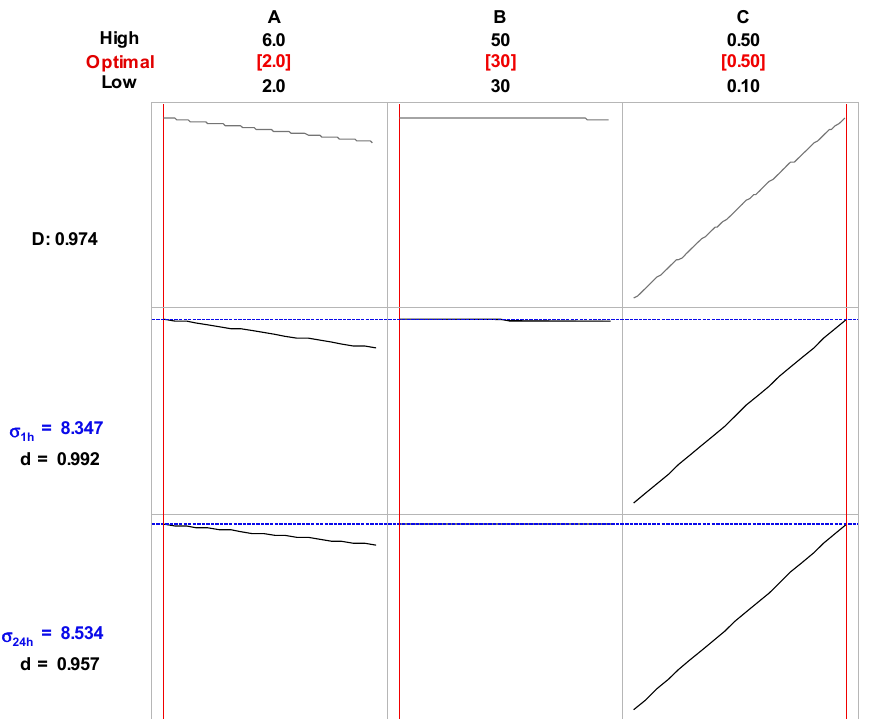
Figure 2. Optimization plots–the effect of the flow rate of the FLC solution ( A ), the discharge current of the FLC-dc-APGD system ( B ), and the NH 4 NO 3 concentration ( C ) on electrical conductivity of PALs produced in the continuous-flow FLC-dc-APGD system, as measured after 1 h ( σ 1h ) and 24 h ( σ 24h ).